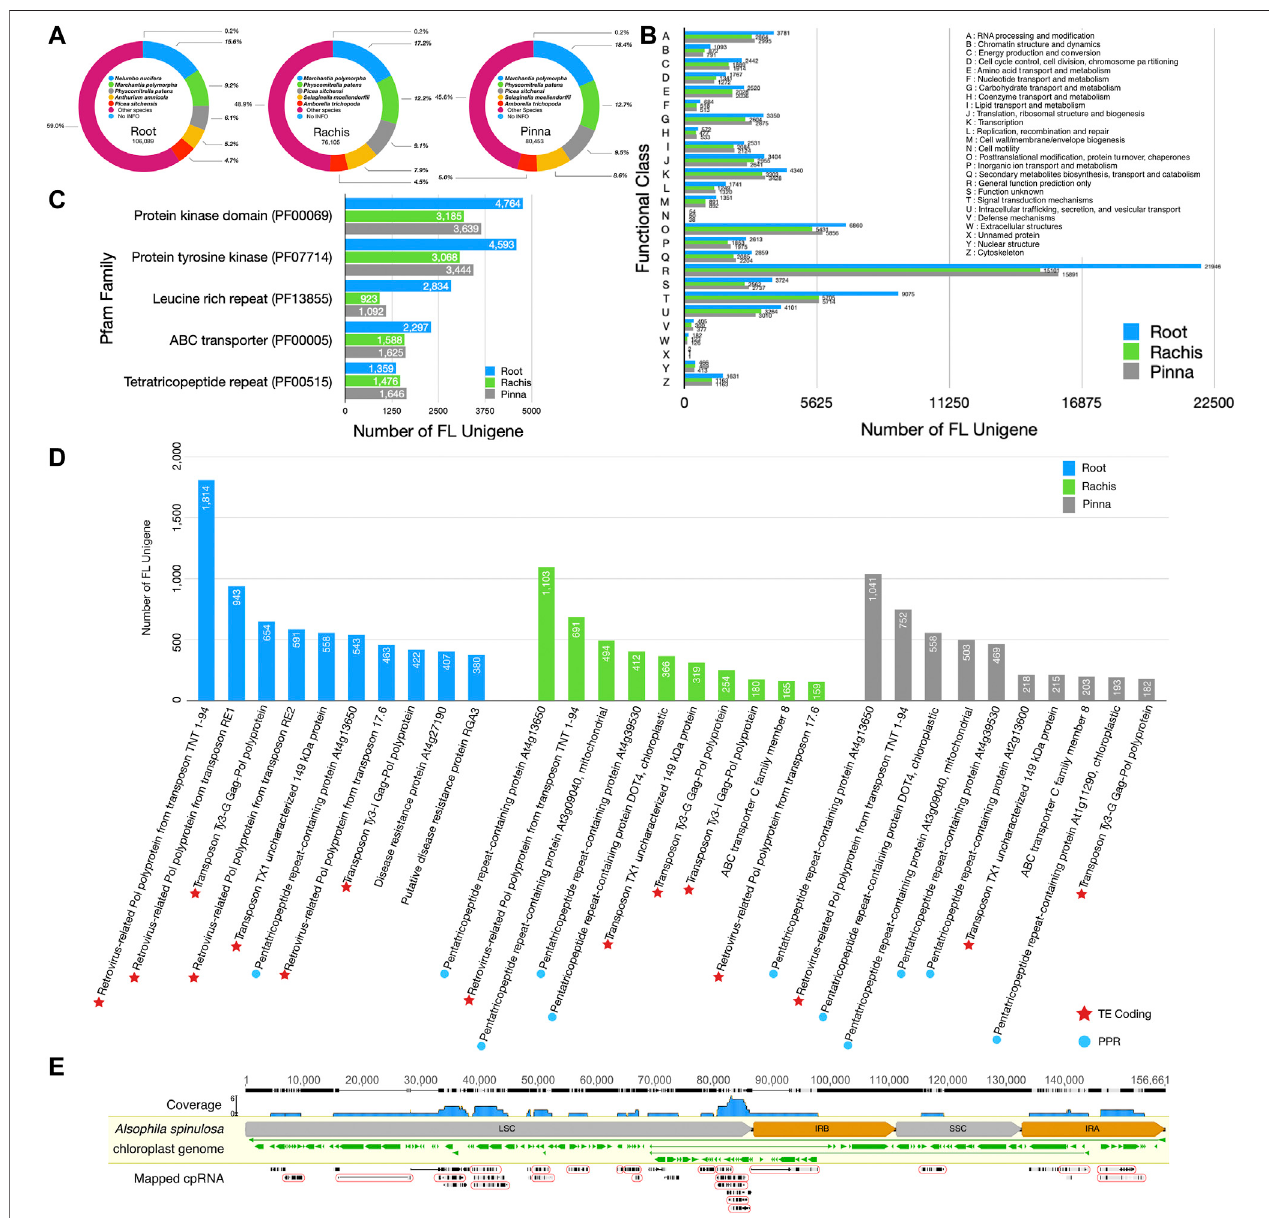
FIGURE2| TheNR,Pfam,KOG,andSwiss-ProtdatabasesannotationstatisticsofthreeorganFLtranscriptomesandcpRNAidenti fi cationfromNTdatabase. (A) Thetop fi vespeciesdistributionofbestBLASTXhitsagainsttheNRdatabase. (B) KOGfunctionalclassi fi cationofFLunigenes. (C) Thetop fi veproteinfamiliesannotated toeachorgantranscriptomeinthePfamdatabase. (D) ThetoptenmostannotatedproteinsperorgantranscriptomeintheSwiss-Protdatabase. (E) Resultsofmapping FL unigenes to the chloroplast genome. In the “ mapped RNA ” row, the grey and black bars indicate matching and mismatching with the chloroplast genome, respectively. The thin lines indicate the gap in the alignment. The mapped cpRNA in the circle are fusion transcripts.